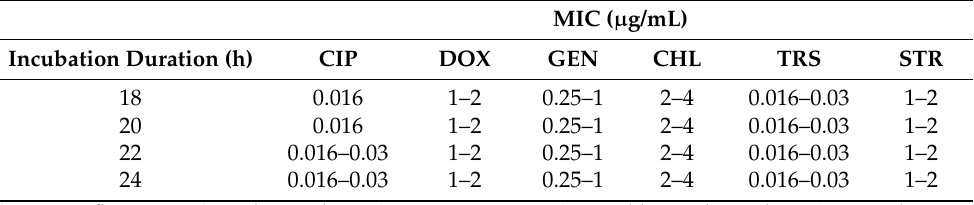
Table 8. Etest MIC values of Y. pestis at various time